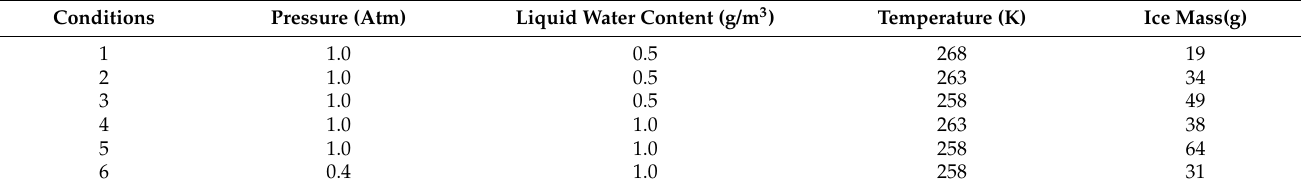
Table 2. The environment parameters and the ice mass of six conditions.